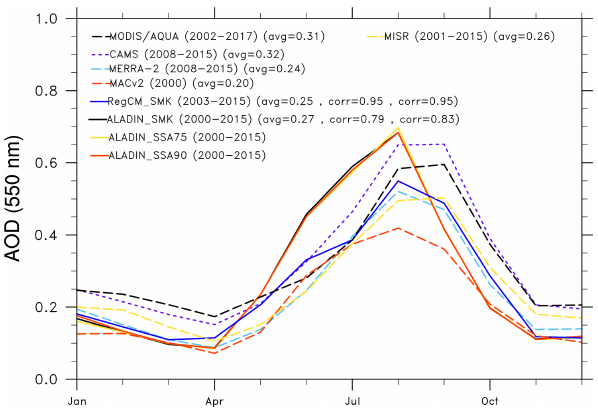
Figure 6. Monthly-mean SSA (550nm) averaged over the Box_S (15–25 ◦ E/5–15 ◦ S) for the ALADIN (2000–2015), and RegCM (2003–2015) models and the MACv2 climatology. The CTL, SMK_75 and SMK_90 ALADIN simulations are